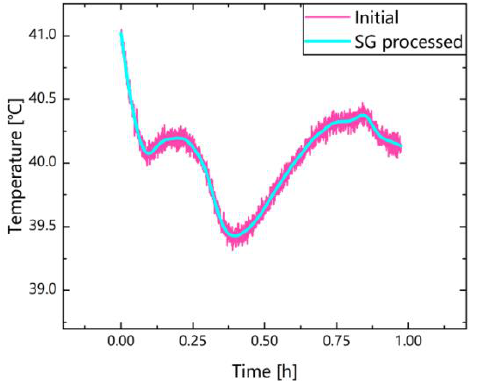
Figure 2. Comparison of initial temperature curves and processed by SG.